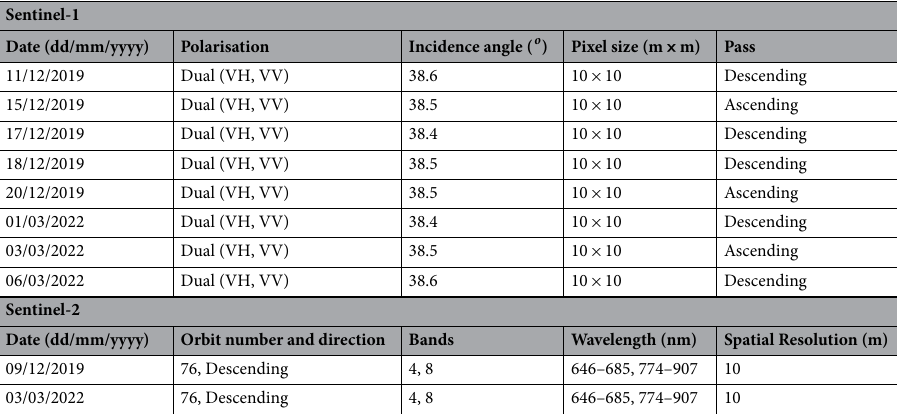
Table 1. Detailed descriptions of the Sentinel-1/2